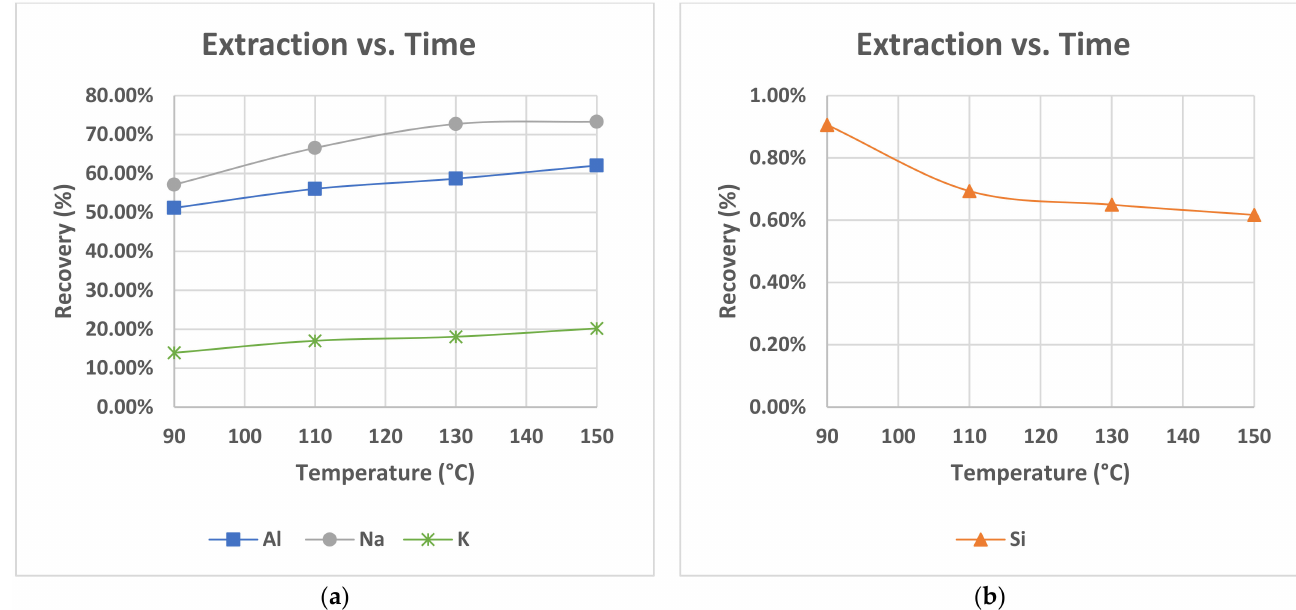
Figure 5. Effect of temperature on the extraction of ( a ) Al, K, Na and ( b ) Si values (pulp density: 2.5% w / v , retention time: 6 h, stirring rate: 300 rpm, HCl concentration: 5.89